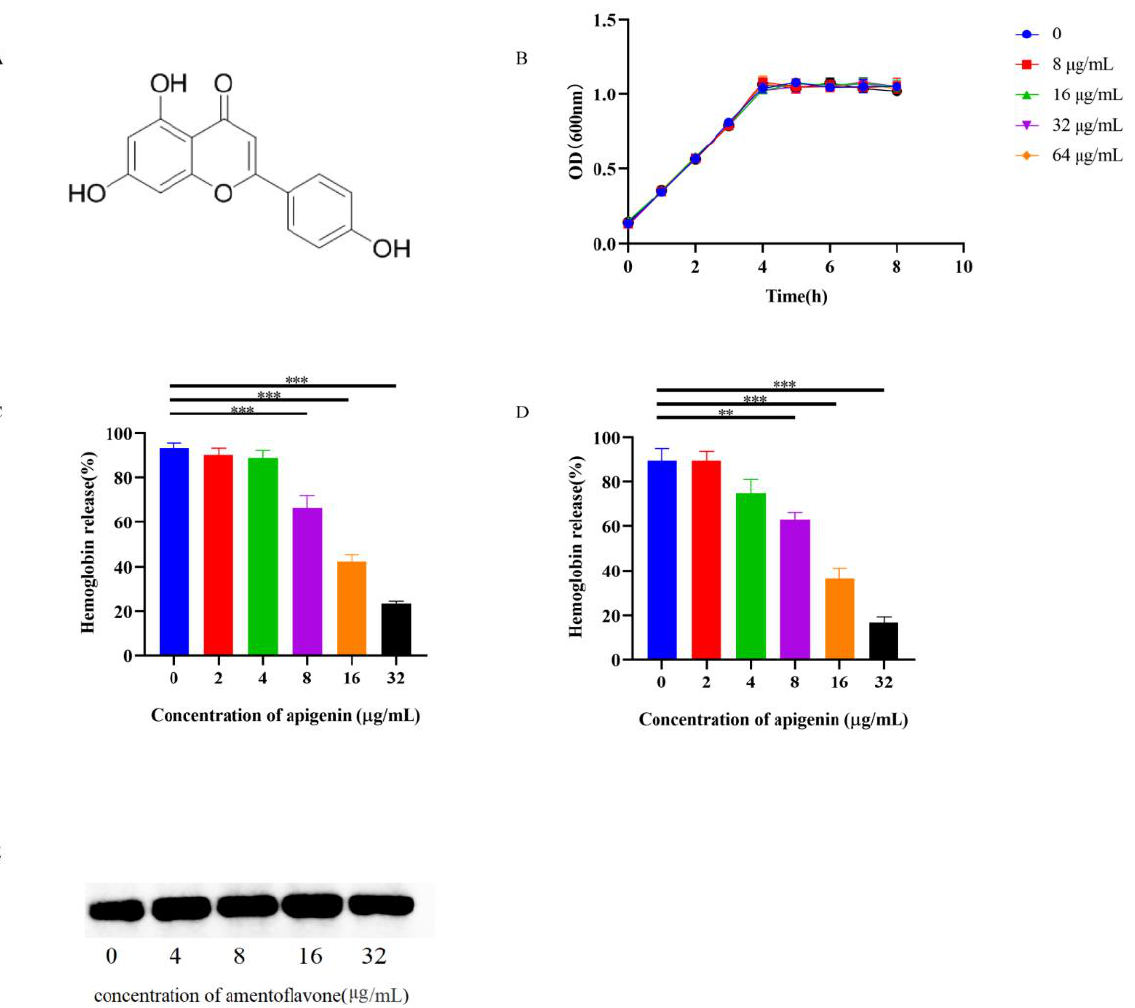
Figure 1. Apigenin inhibits the hemolytic activity of suilysin (SLY). ( A ) 2D structure of apigenin. ( B ) The growth curve of SC19 was determined. SC19 was cultured with 5% fetal bovine serum and treated with different concentrations of apigenin. ( C ) Hemolytic activity of supernatants from SC19 and apigenin co-culture system. ( D ) Effect of apigenin on hemolytic activity of purified SLY (100 ng/mL). ( E ) The expression of SLY was detected in the culture supernatant with or without apigenin. The data was obtained through three independent experiments. ** p < 0.01 , *** p < 0.001 versus SS2 alone.